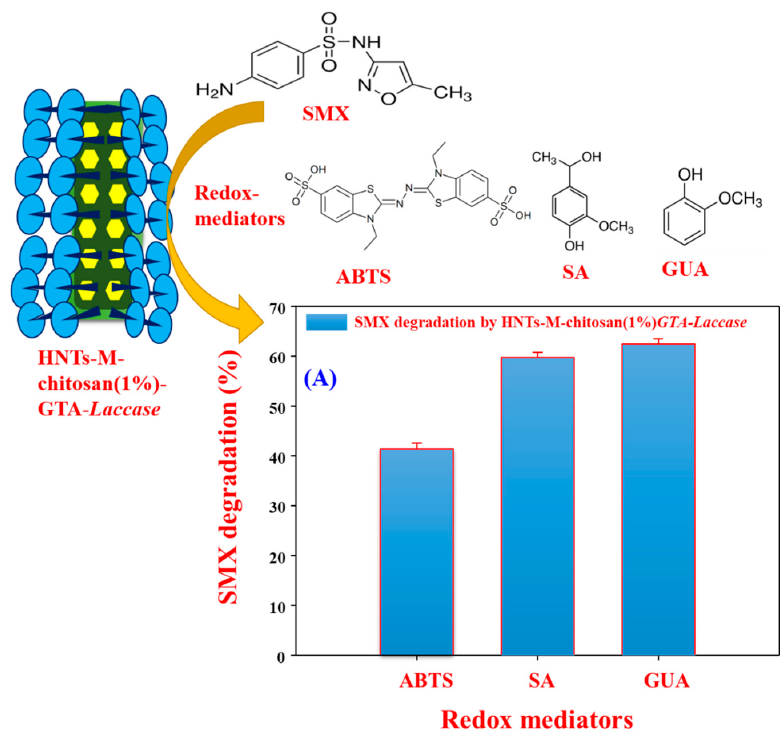
Figure 10. Schematic representation of redox-mediated SMX degradation by HNTs-M-chitosan (1%)-GTA- Laccase and ( A ) Data of SMX degradation by HNTs-M-chitosan (1%)-GTA- Laccase at pH 4.2 and 25 °C.